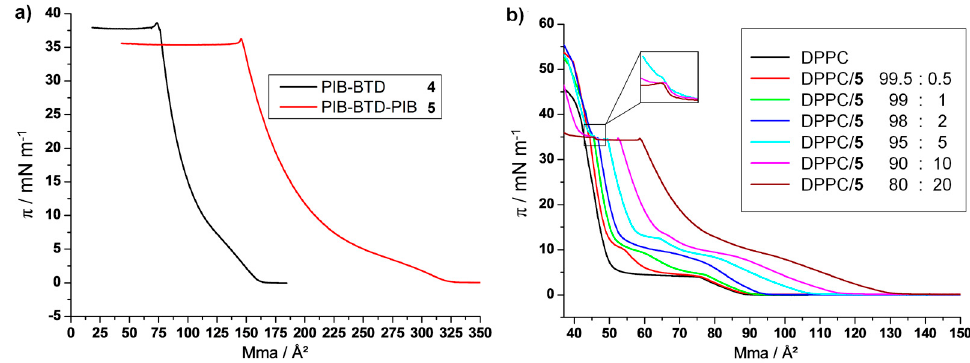
Figure 2. π -A isotherms of ( a ) the pure PIBs 4 and 5 and ( b ) DPPC/ 5 mixtures at 20 °C. The black curve represents the isotherm of the pure DPPC and the different colored curves represent the different molar ratios of the DPPC/polymer mixtures.